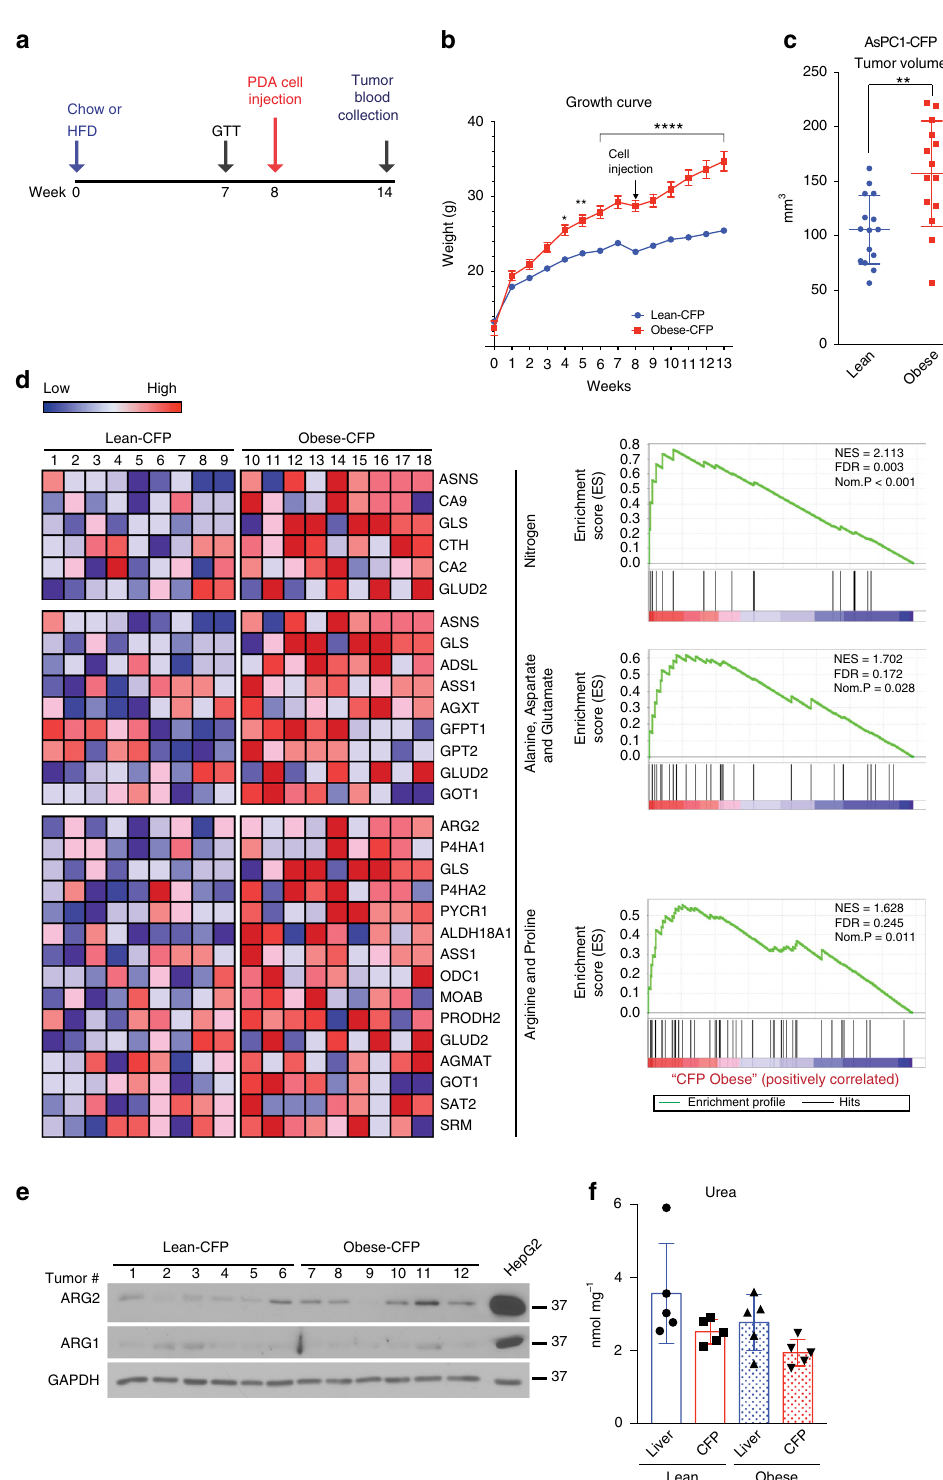
Fig. 1 Obesity leads to enhanced PDA growth and transcriptional induction of nitrogen and arginine metabolism. a Schematic timeline for the generation of lean or obese orthotopic xenograft models of PDA, using 4 – 6 week old male Rag1 − / − mice. b Growth curves of Lean-CFP ( n = 15) or Obese-CFP ( n = 14) mice. Arrow indicates orthotopic injection of AsPC1-CFP cells (10 5 per mouse). c Volumes of orthotopic PDA tumors from mice in b . d Heatmaps ( left ) of genes enriched in metabolic pathways in Lean-CFP compared to Obese-CFP tumors ( n = 9 per group), with corresponding GSEA plots ( right ). Red indicates higher expression , and blue lower expression , relative to the mean expression level within each group. NES normalized enrichment scores, FDR false discovery rate, Nom. nominal. e Immunoblots for ARG2 and ARG1 in representative orthotopic tumors from c . f Graph demonstrating that the urea levels in PDA tumors are comparable to those in the liver of lean or obese mice ( n = 5); data are representative of three independent experiments. In b , data represent the mean ± s.e.m. In c , f , data represent the mean ± s.d. * P ≤ 0.05, ** P ≤ 0.01, **** P ≤ 0.0001, two-way ANOVA followed by Tukey test in b and t -test in